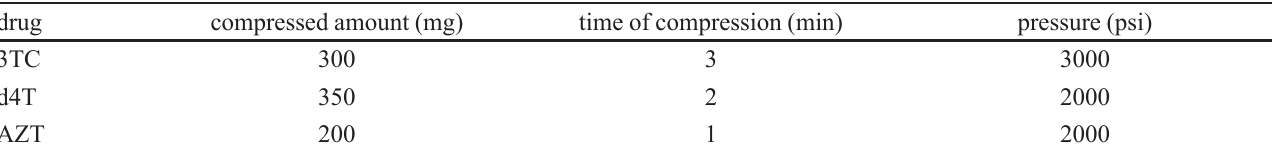
TABLE I - Conditions adopted for each antiretroviral drug to obtain disks for intrinsic dissolution study